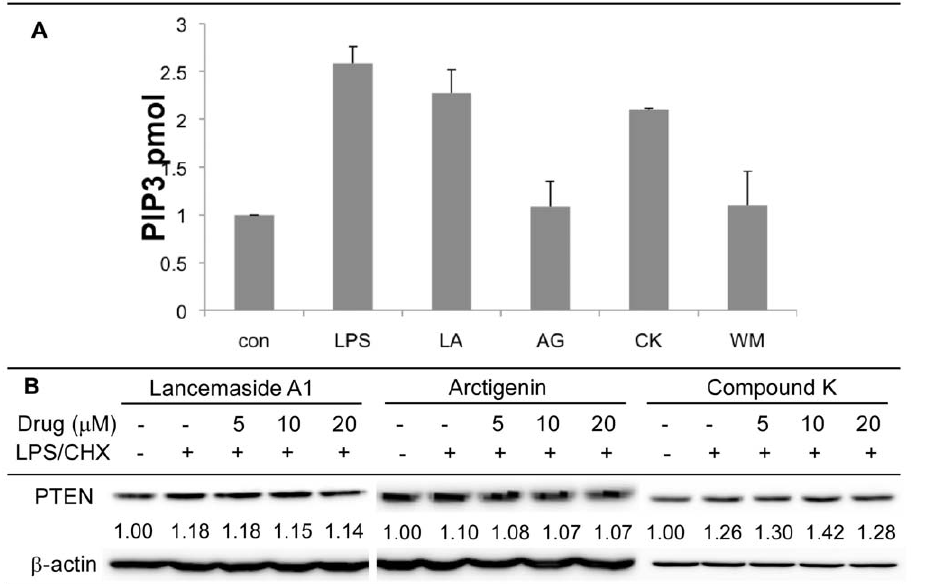
Figure 4. Determining the effects of three screened compounds on membrane PIP3 and PTEN levels. ( A ) Tat-expressing CHME5 cells were treated with and without LPS/CHX in the presence of the three different drug compounds at 20 m M for 20 minutes. Cell lysates were prepared for determining the membrane PIP3 level. Data were calculated by generating a standard curve of known concentrations for PIP3 provided from the manufacturer (Data S2). Control (Con), no treatment; LPS, 50 m g/ml LPS and 10 m g/ml cycloheximide; Lancemaside A1 (LA), Arctigenin (AR), Compound K (CK) and Wortmannin (WM). ( B ) Tat-expressing CHME5 cells were treated in the presence or absence of LPS/CHX and 5, 10, and 20 m M of each drug for 20 minutes. Cellular membrane fractions were processed and examined by western blot analysis for PTEN. b -actin was used as a loading control. The fold changes in the PTEN level were determined as described in methods.